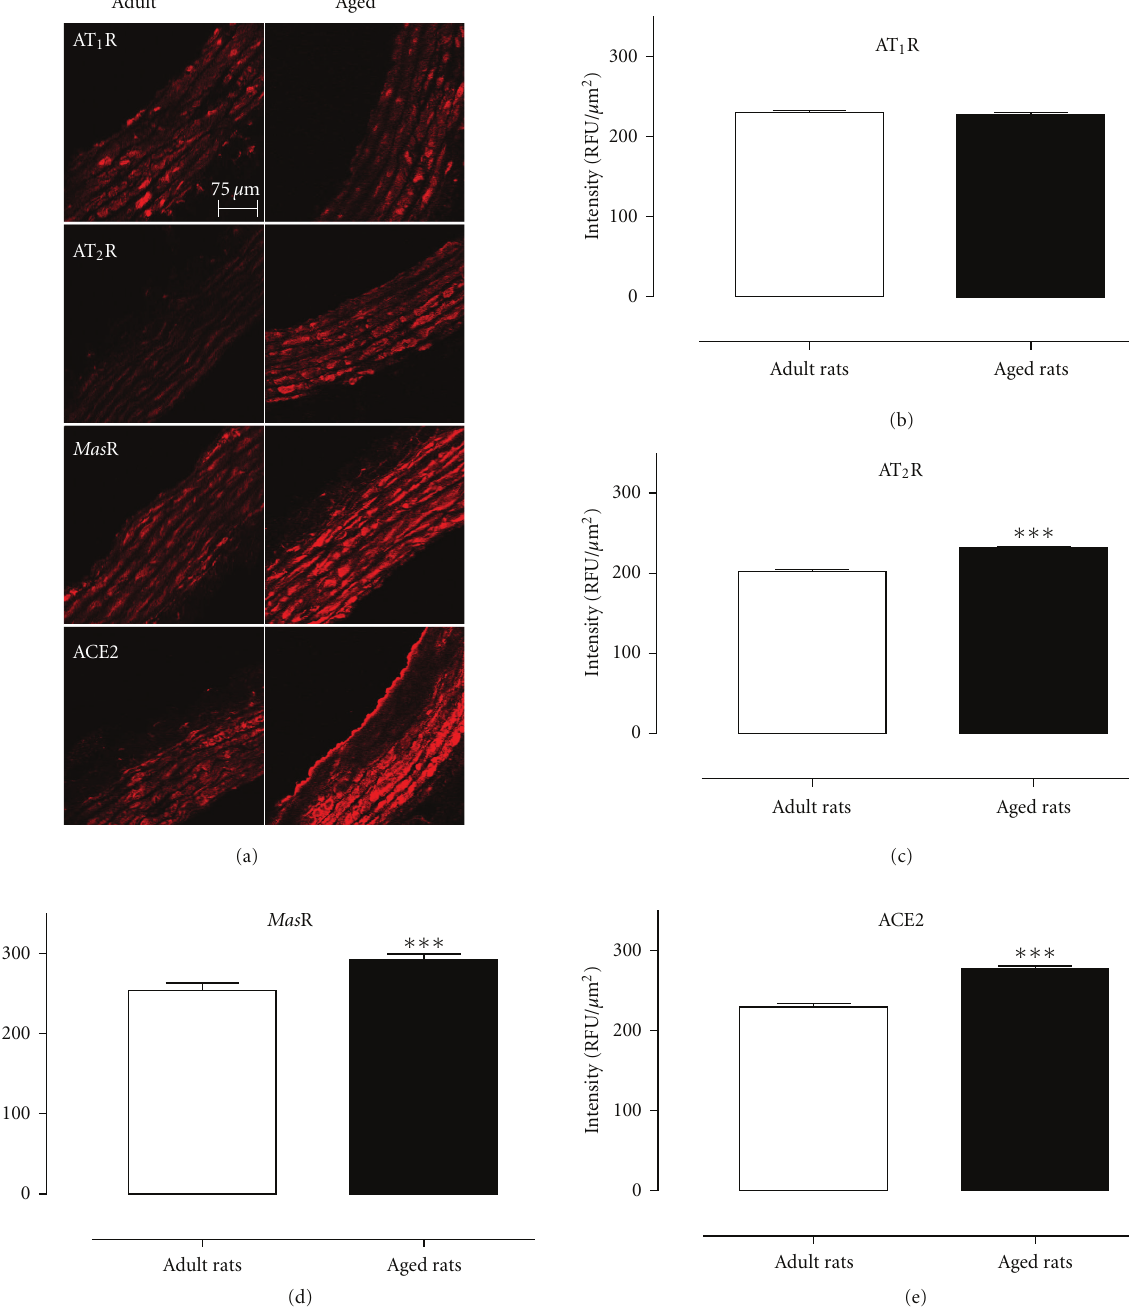
Figure 4: (a) Representative immunolocalisation images of AT 1 R, AT 2 R, Mas R, and ACE2 in adult WKY rats and aged WKY rats. Mean data for aortic expression of the (b) AT 1 R, (c) AT 2 R, (d) Mas R, and (e) ACE2 expressed as relative fluorescent units in adult ( n = 5) and aged ( n = 4) WKY rats. ∗∗∗ P < 0 . 001 versus adult WKY